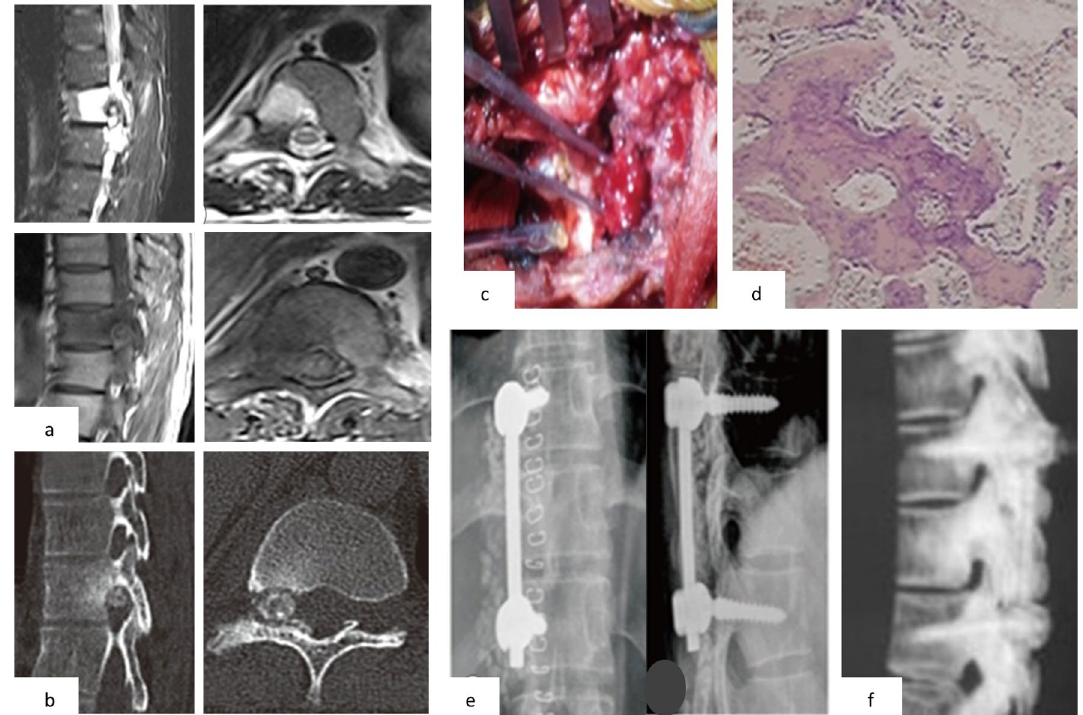
Fig. 1 Case 1 a T1w and T2w MRI showing extraosseous foraminal lesion with vertebral body edema, b CT sagittal and axial section showing extraosseous lytic lesion with sclerotic rim in neural foramen, c excised tumor mass, d HPE slide confirming osteoblastoma, e Post-operative AP and lateral X-ray confirming implant positioning, f 5 years follow-up CT scan showing